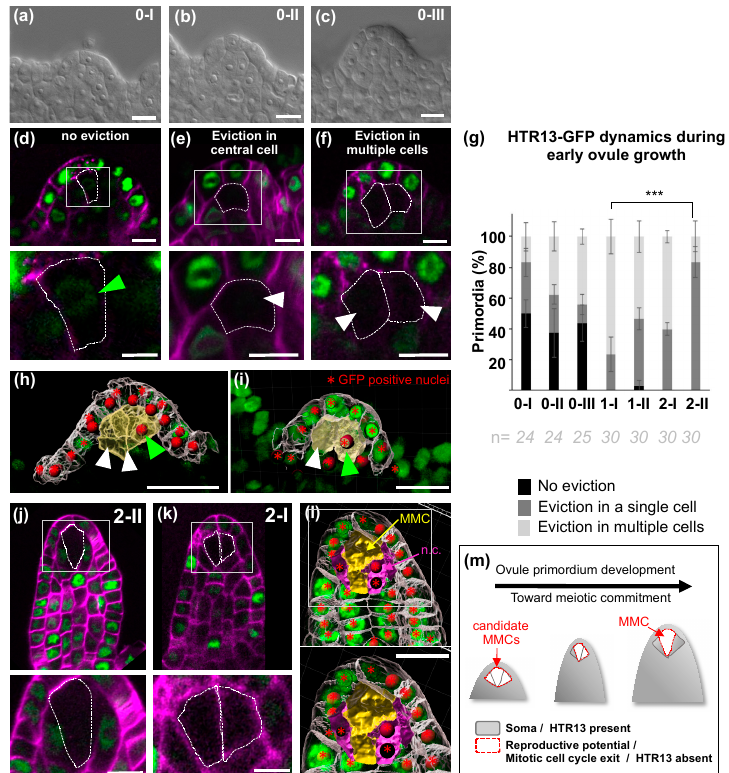
Figure 1. Specific dynamics of HTR13-GFP (H3.1) chromatin-deposition during early Arabidopsis ovule development. ( a – c ) Representative image of cleared ovules preceding stage 1-I (stages 0-I to 0-III), used for quantitative analysis. ( d – f ) Representative images of emerging ovule primordia showing the three different HTR13 patterns detected in subepidermal cells of the nucellus: ( d ): Ovule primordium showing no eviction of HTR13 at the MMC (Megaspore Mother Cell). Green arrow in the inset shows the nuclei of the MMC with GFP signal. ( e ) Ovule primordium showing HTR13 eviction (white arrow) in a single subepidermal cell. ( f ) Ovule primordium showing HTR13 eviction in two subepidermal cells (white arrows). ( g ) Frequency of ovule primordia exhibiting the distinct HTR13 patterns within subepidermal cells in the nucellus. Standard Error (SE) is indicated, n = number of ovules observed. Two-tailed Fischer’s test was used to compare the proportion of eviction in a single cell between stage 1-I and 2-II. *** p < 0.001. ( h – i ) 3D reconstructions of cell surfaces showing nuclei GFP signal detection (red stars) in all epidermal cells (greysurfaces), andonlyinoneoutofthree( h )orinoneoutoftwo( i )subepidermalcells(yellowsurfaces). ( j ) Ovule at stage 2-I showing eviction in the MMC and not in companion cells. ( k ) Ovule at stage 2-II showing eviction in two enlarged subepidermal cells. ( l ) 3D reconstruction of cell surfaces showing nuclear GFP signalinallepidermalcells, inMMCneighborcells(magentasurfaces, n.c.) andevictionintheMMC(yellow surface). ( m ) Working model: At early stages of ovule primordium development, HTR13 eviction and cell cycle exit occur in several subepidermal cells, distinguishing them from the somatic tissues (soma). This eviction persists in the MMC, which will undergo meiosis. Conversely, HTR13 is gradually re-incorporated in the neighbor cells of the MMC, which re-enter the soma. Squares mark inset regions. Dashed lines mark MMC or candidate MMCs. Green: GFP fluorescence; Magenta: cell wall marker RenaissanceSR2200; scale bars: 10 µ m.( a – c ) DIC microscopy.( d – f , j , k )LaserScanningConfocalMicroscopy. ( h , i , l ) 3D reconstruction of cell surfaces after epidermal and subepidermal cell segmentation and automated nuclei